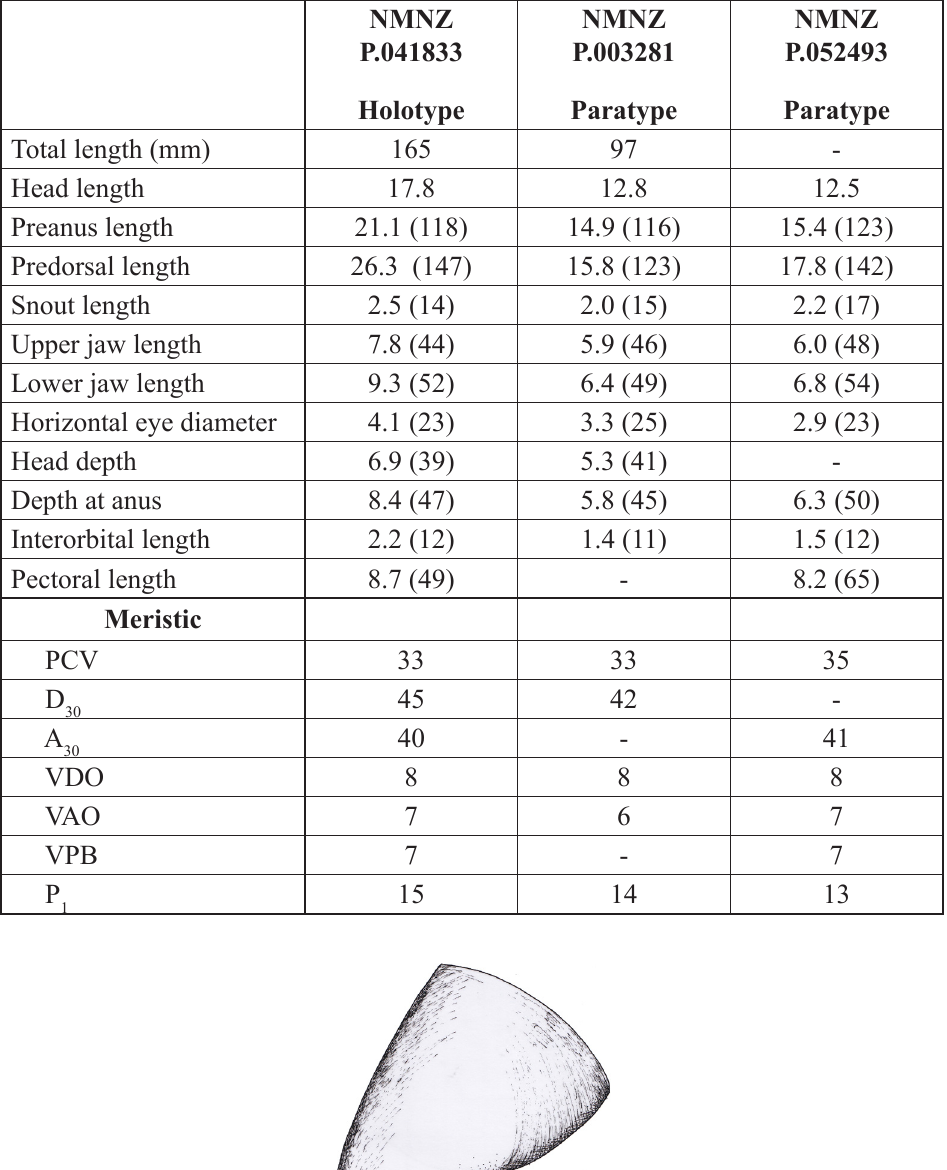
Table 1. Morphometric (mm) and meristic data for Echiodon prionodon sp. nov. Numbers in brackets refer to measurements in % head